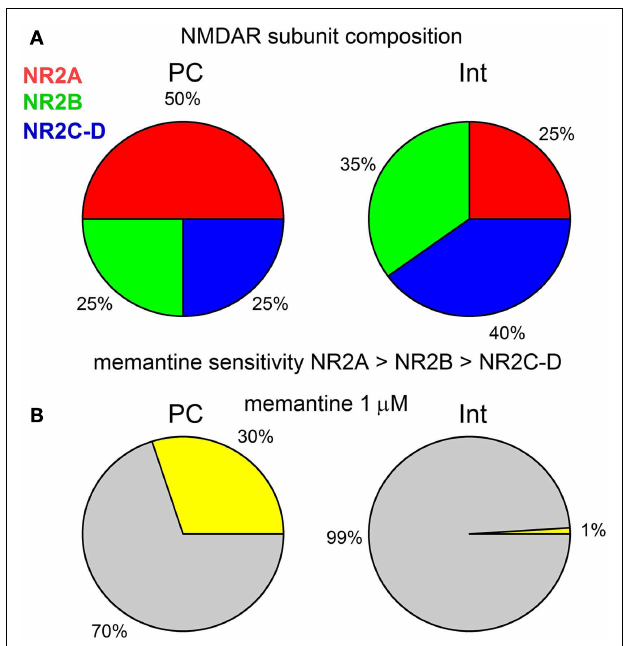
FIGURE 7 | (A) Graphical description of the NMDAR subunit composition of PCs and Ints in the CA1 region of the rat hippocampus. (B) Graphical representation of the effect of 1 µ M memantine on the NMDAR currents in PCs and Ints.The percentage of NMDAR currents blocked by memantine is represented in yellow. Note that for clarity the values are shown without standard